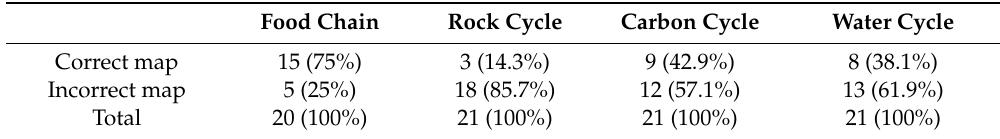
Table 2. Analysis of the 83 elaborated concept maps.